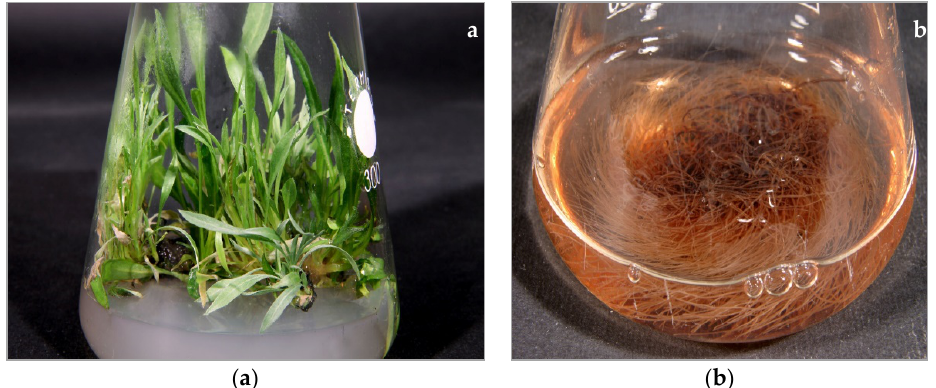
Figure 4. Rindera graeca in vitro culture: ( a ) shoots cultivated on solid DCR medium supplemented with BAP 0.5 mg/L; ( b ) hairy roots maintained in liquid DCR medium